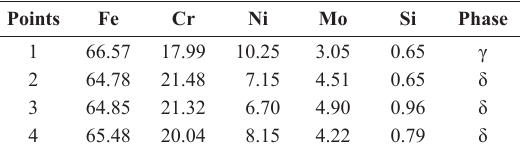
Table 3. Chemical composition analyzed by EDS of points selected in Figure 2a (wt.%).